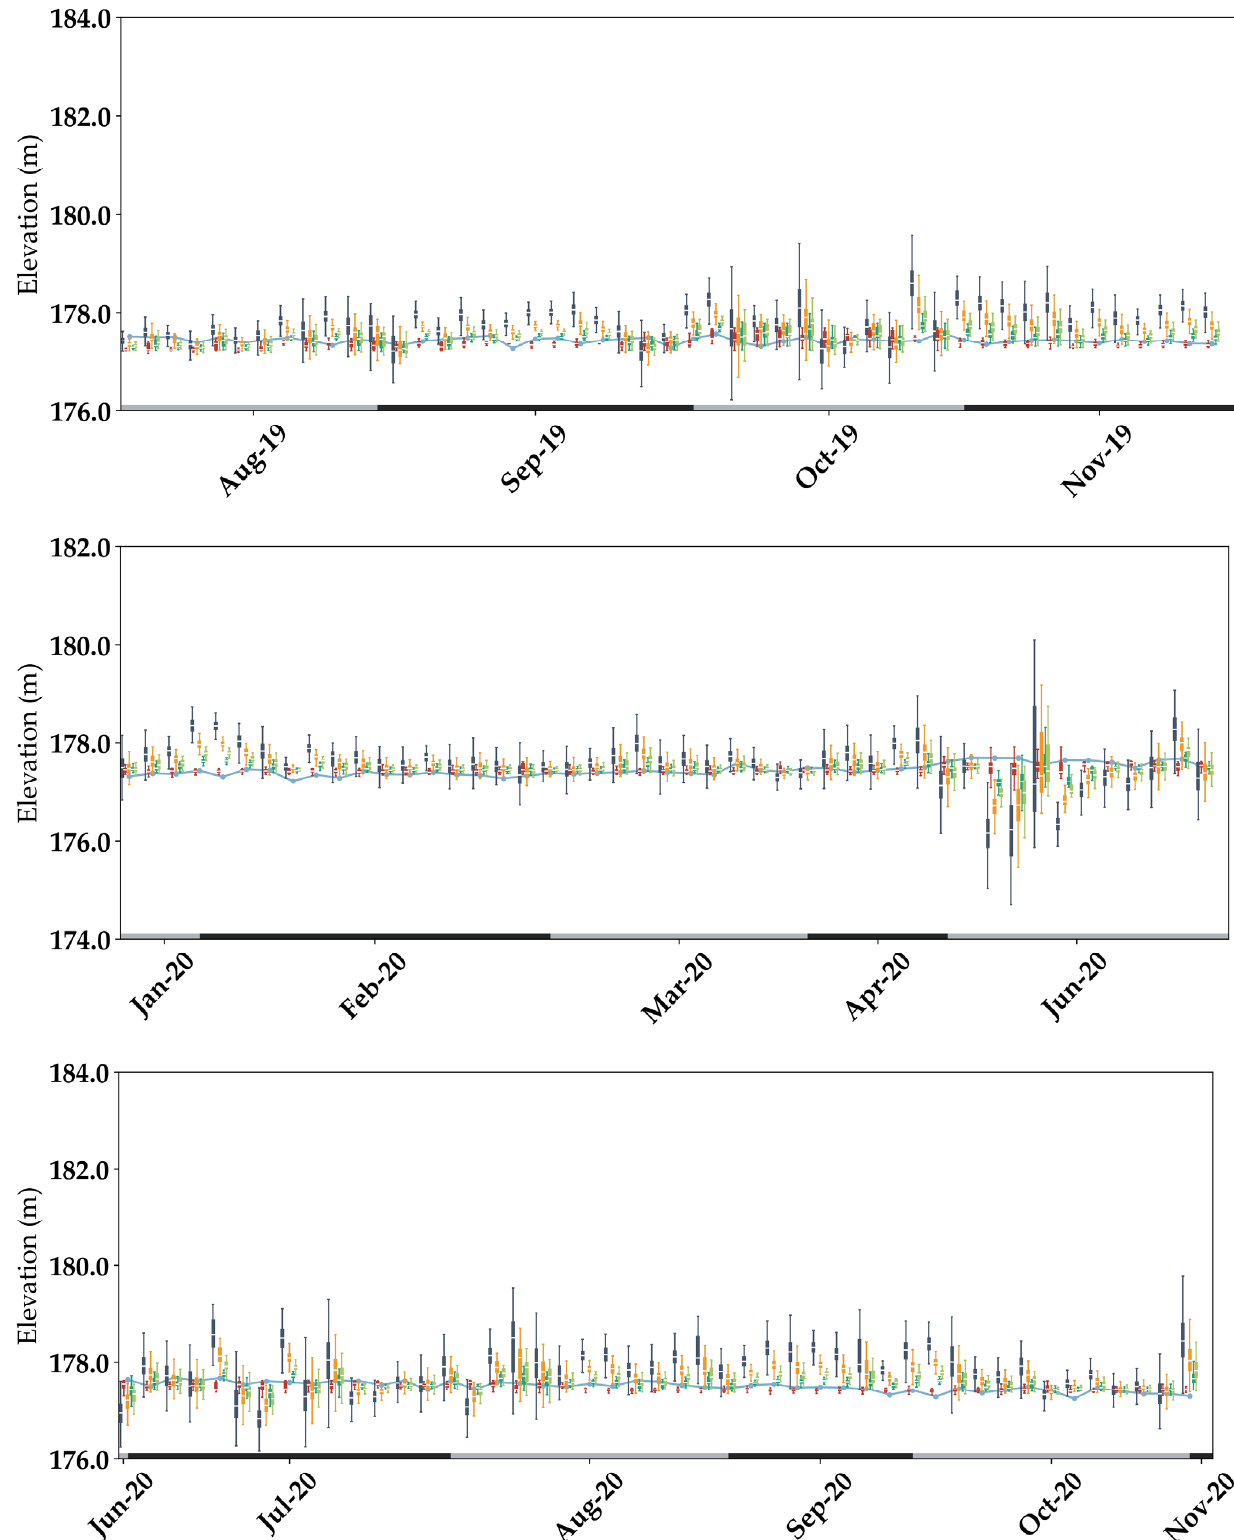
Figure A4. Boxplot by track of the original estimated elevations by GEDI over Lake Michigan and the four tested models presented in Sections 3.1.1 and 3.1.2. The blue line represents in situ